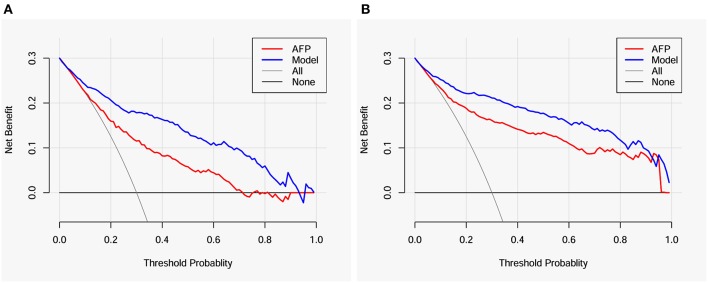
Decision curves for the model and AFP. (A) Patients with AFP < 400 μg/L; (B) all patients. AFP, alpha-fetoprotein.